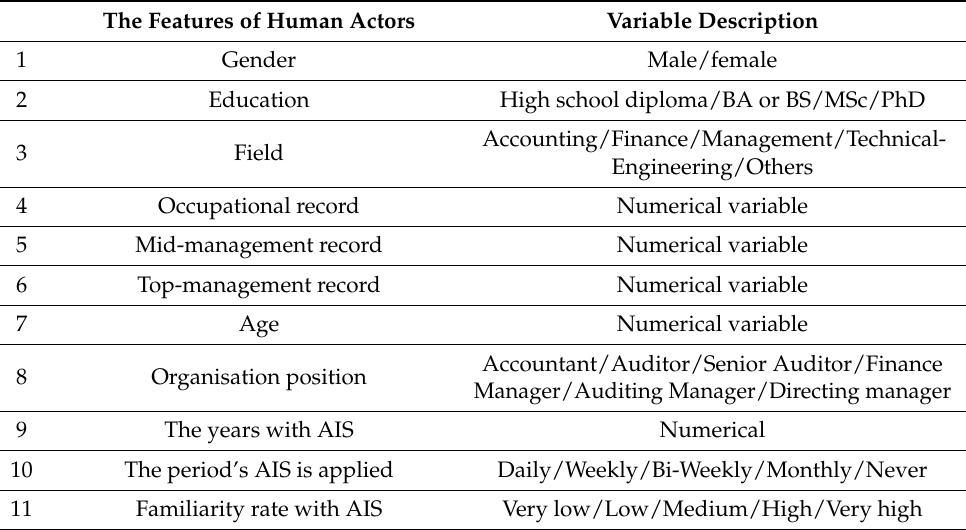
Table 1. Detailed information on the considered